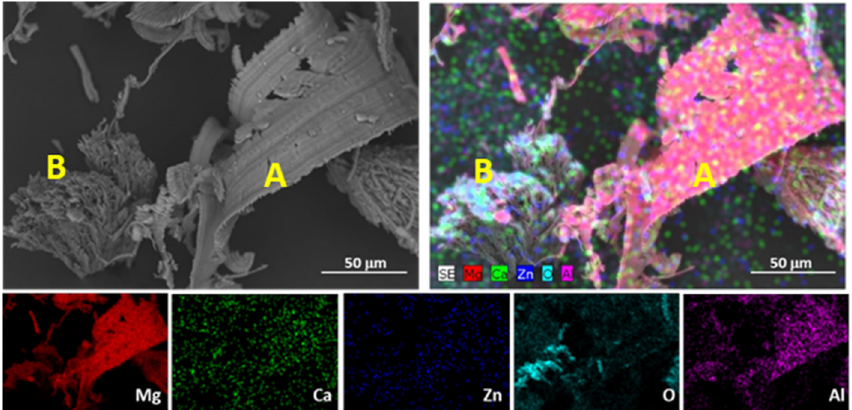
Figure 12. SEM micrograph and EDS analysis of the wear debris found in the over-aged ZX30 alloy samples at 20 N and 0.1 m s − 1 . A and B correspond to zones with different composition: A is richer in Al, and B is richer in